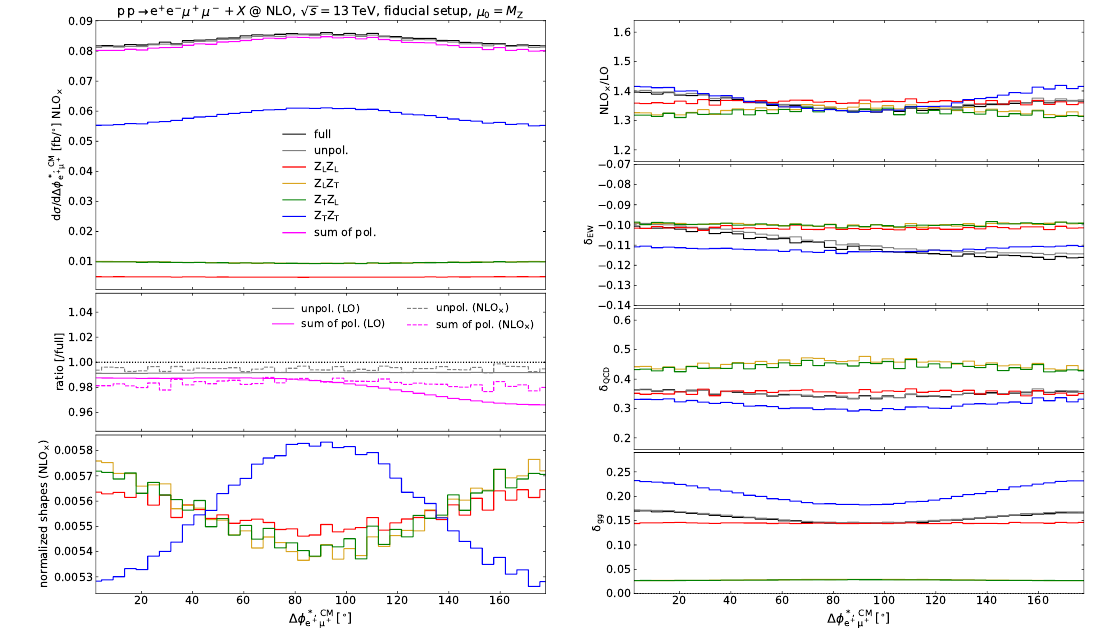
and φ ∗ , CM , where e + µ +